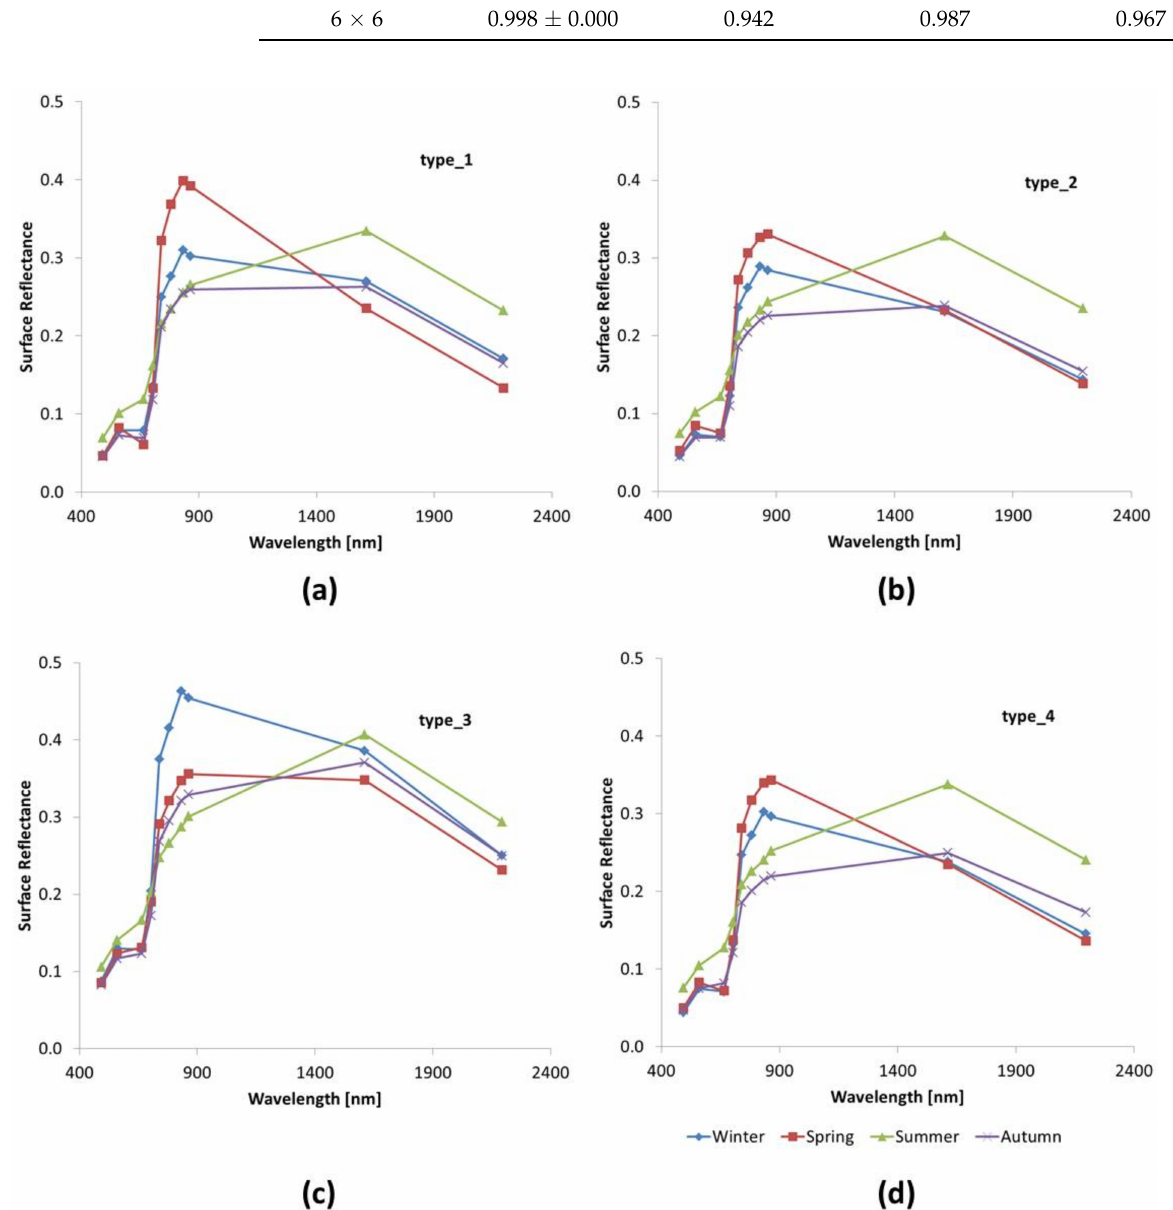
Figure 7. Comparison among the multi-seasonal surface reflectance curves of the four grassland habitats under